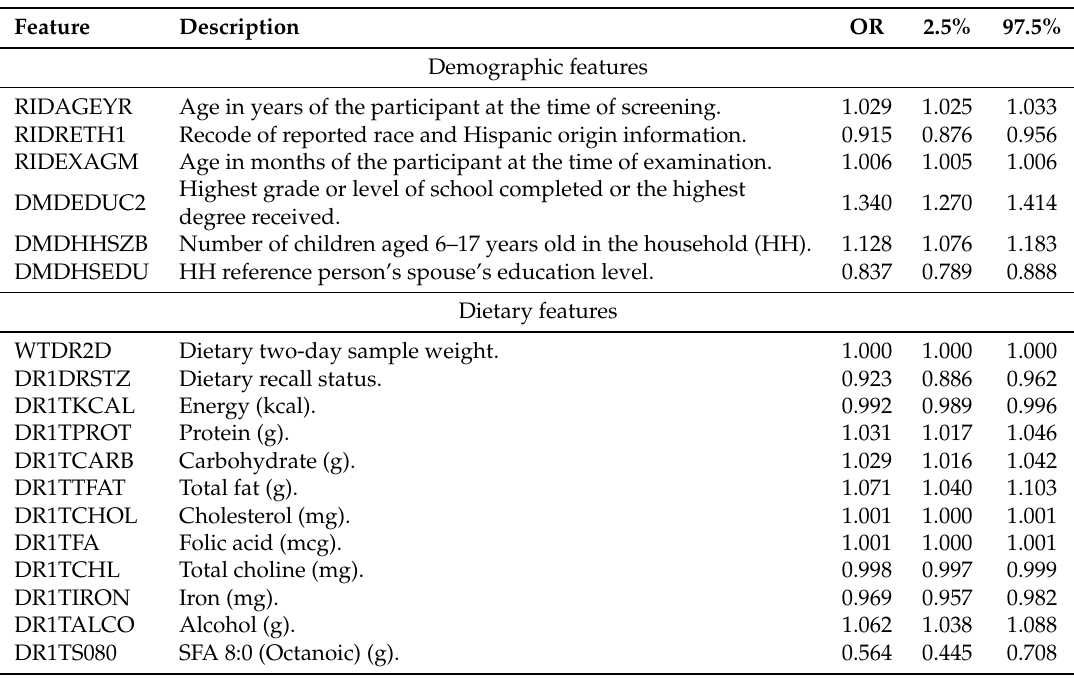
Table 4. OR values and confidence intervals (2.5%/97.5%) obtained by the statistical analysis of the multivariate model corresponding to age group 3, containing 6 demographic features and 12 dietary features.